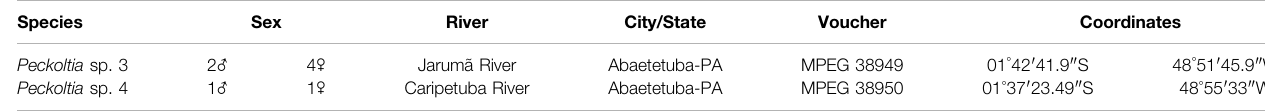
TABLE 2 | Samples and collection sites for Peckoltia species analyzed in this study. Species